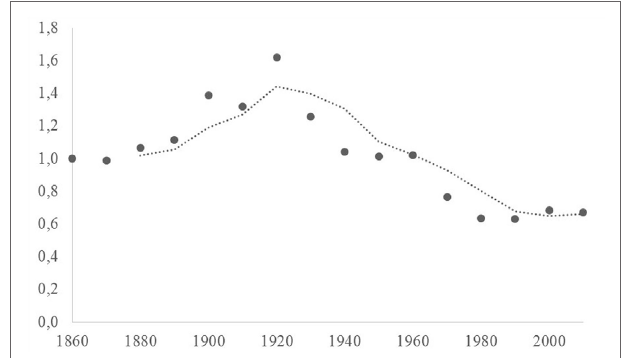
FigUre 2 | Provincial inequality coefficient in Spain (NUTS-3) between 1860 and 2010. Y axis: 1860 = 1; X axis: Year. No permission is required for the use and reproduction of this data. Source: Tirado et al. (2016), p.